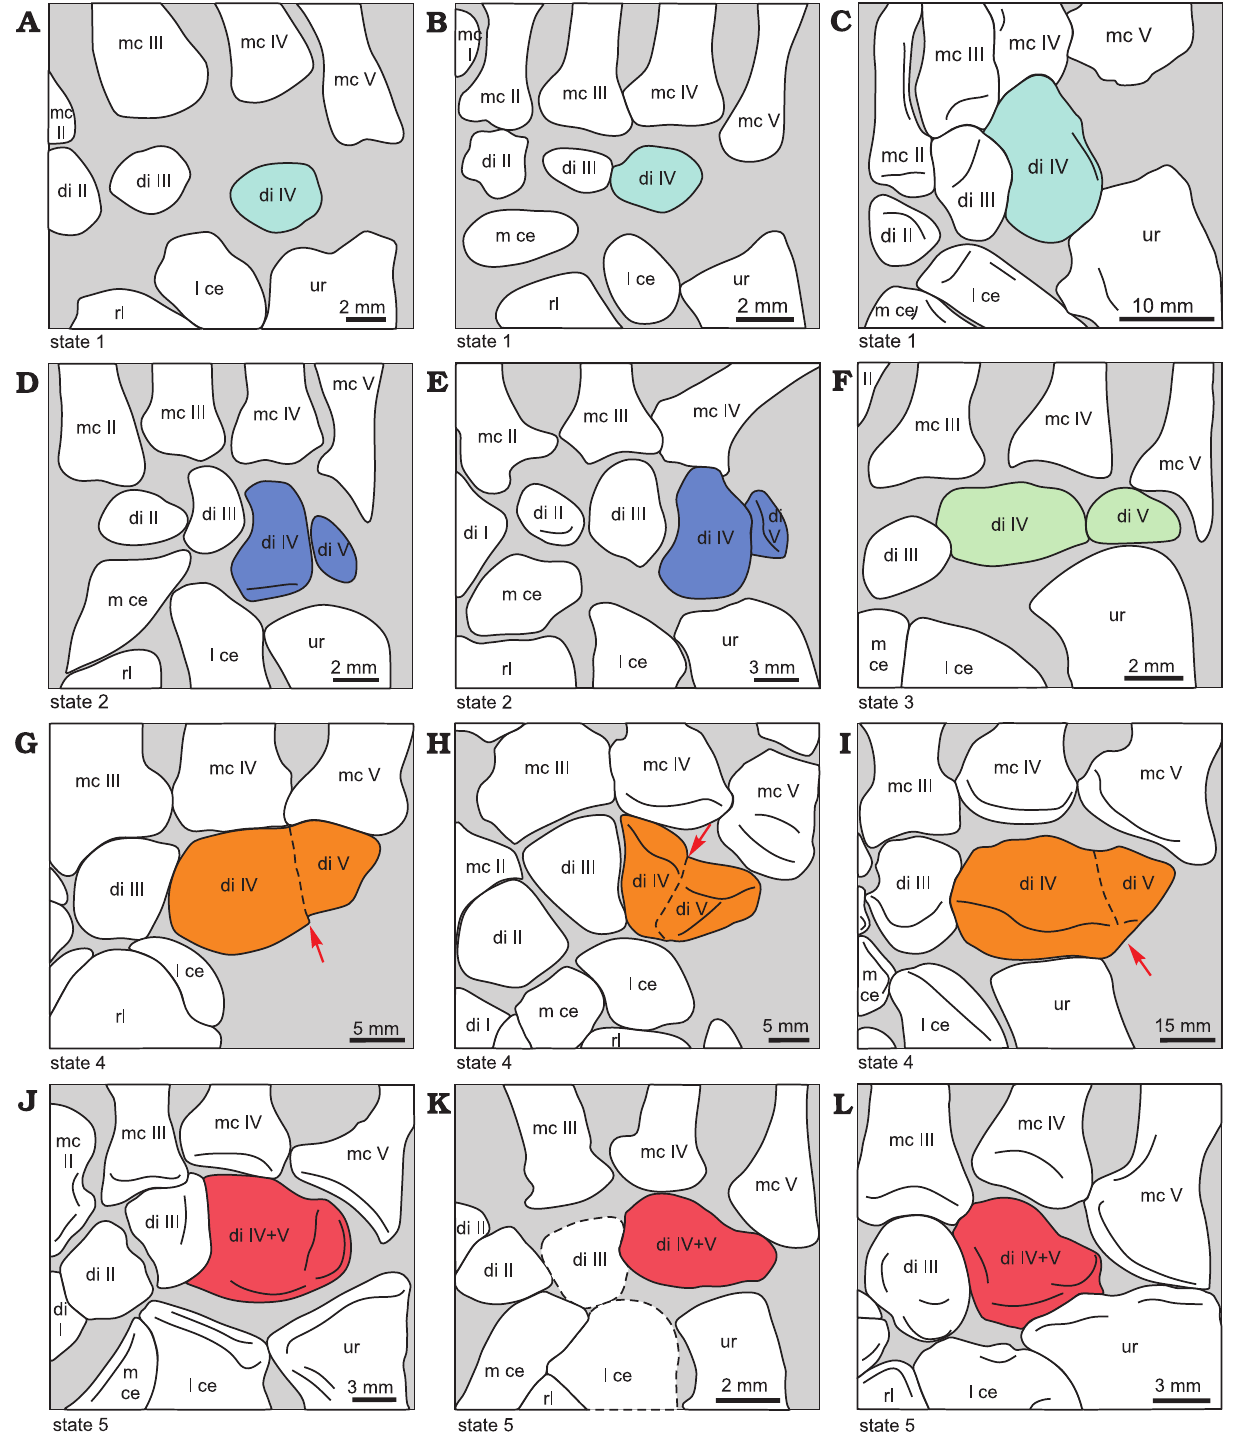
Fig. 16. Selected specimens showing the different states of distal carpal V in gorgonopsians, therocephalians, and cynodonts, all in dorsal view (except A, ventral view). A . Olivierosuchus parringtoni (Brink, 1965), BP/1/3973, left carpus. B . Tetracynodon darti Sigogneau, 1963, AM 3677, right carpus. C . Tru­ cido cynodon riograndensis Oliveira, Soares, and Schultz, 2010, UFRGS PV-1051T, right carpus. D . Procynosuchus delaharpeae Broom, 1937, BP/1/591, right carpus. E . Procynosuchus delaharpeae Broom, 1937, NHMUK PV R 37054, right carpus. F . Ictidosuchoides longiceps Broom, 1920, CGS CM86-655, right carpus. G . Arctognathus curvimola (Owen, 1876), SAM-PK-3329, right carpus. H . Theriognathus microps Owen, 1876, NHMUK R 5694, right carpus. I . Gorgonopsian BP/1/1210, left carpus (reversed). J . Glanosuchus macrops Broom, 1904, SAM-PK-K7809, left carpus (reversed). K . Ictido suchoides lon­ giceps Broom, 1920, or Ictidosuchops intermedium (Broom, 1938), BP/1/2294, right carpus (dashed lines are shown where the bone margins are uncertain). L . Procynosuchus delaharpeae Broom, 1937, RC92, right carpus. Colours show the different states of distal carpal IV and V. Arrows show lines of fusion (dashes) between distal carpals IV and V. Abbreviations: mc, metacarpals, di, distal carpals; l ce, lateral centrale; m ce, medial centrale; rl, radiale; ur,